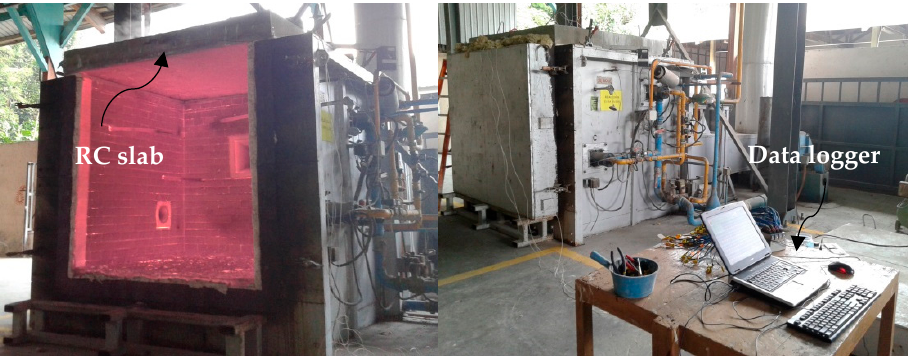
Figure 1. Medium-scale furnace.